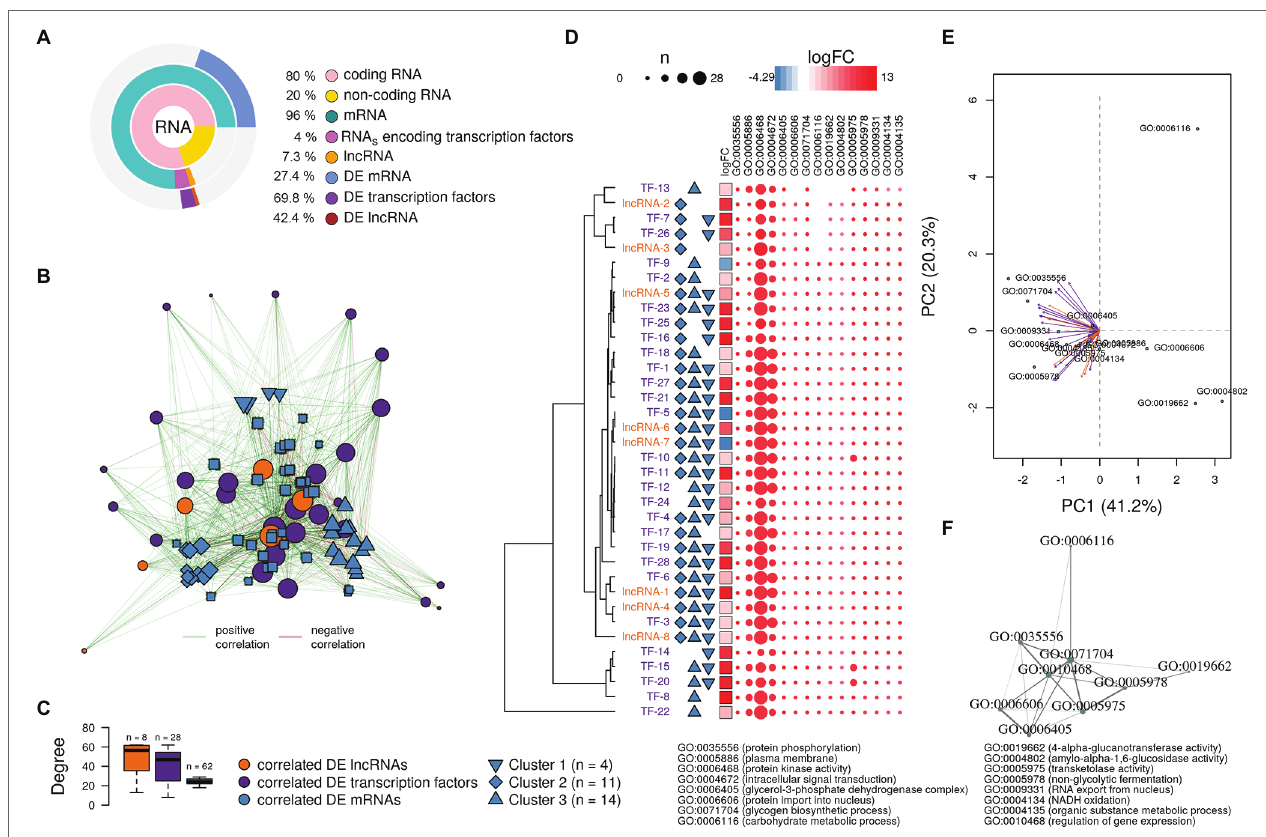
FIGURE 5 | Analysis of the putative function of long non-coding RNAs (lncRNAs) and transcription factors found in the A. sydowii transcriptome (condition of 5.13 M NaCl compared to 1 M NaCl). (A) Relative amounts of differentially expressed (DE) mRNAs, lncRNAs, and RNAs encoding transcription factors (TFs) found in the A. sydowii transcriptome. (B) Topology of the directed network built with the most relevant DE lncRNAs and RNAs encoding TFs and their co-expressed DE mRNAs. (C) Distribution degree of DE lncRNAs and RNAs encoding TFs and their co-expressed DE mRNAs observed in the directed network. (D) LogFC of the selected lncRNAs and RNAs encoding TFs, their association with the identified clusters of DE mRNAs, and a heatmap of the counts of DE mRNAs that each regulatory molecule was correlated per GO term of interest. (E) Canonical correspondence analysis of the selected lncRNAs and RNAs encoding TFs and the GO terms related to biological functions relevant to overcome extreme osmotic stress. (F) Semantic similarity analysis of the GO terms annotated to DE mRNA co- expressed with DE lncRNAs and RNAs encoding